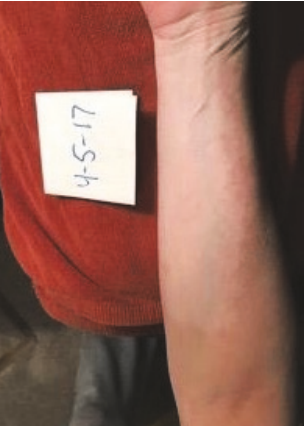
Figure 4: Clinical appearance of the right anterior forearm 13 months after using apremilast 30 mg twice